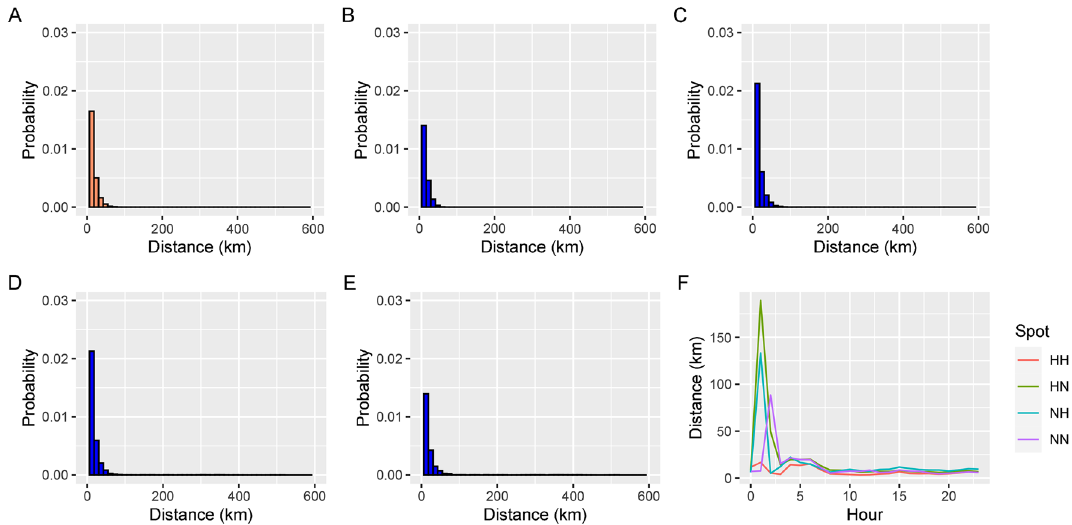
Figure 6. Trip distance distribution and travel distance by time of day for HH, NH, HN, and NN flow